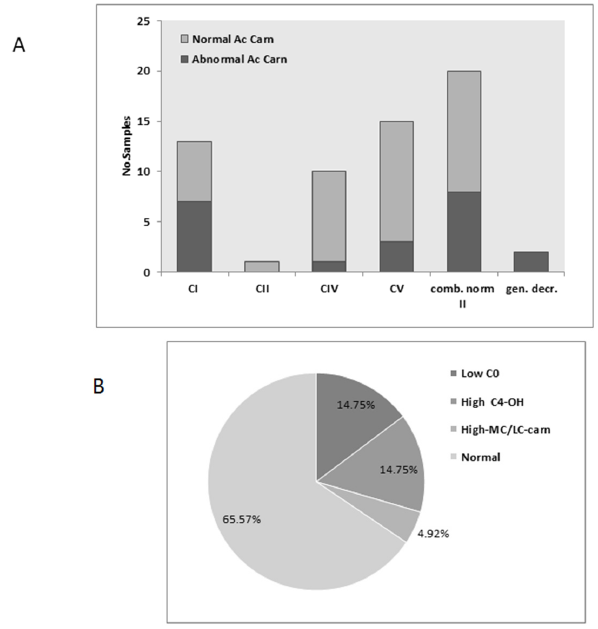
Figure 3. Plasma acylcarnitines: ( A ) The relative proportion abnormal to abnormal acylcarnitines (Ac. Carn) tests results according to groups; ( B ) The relative proportion of the most common abnormalities.